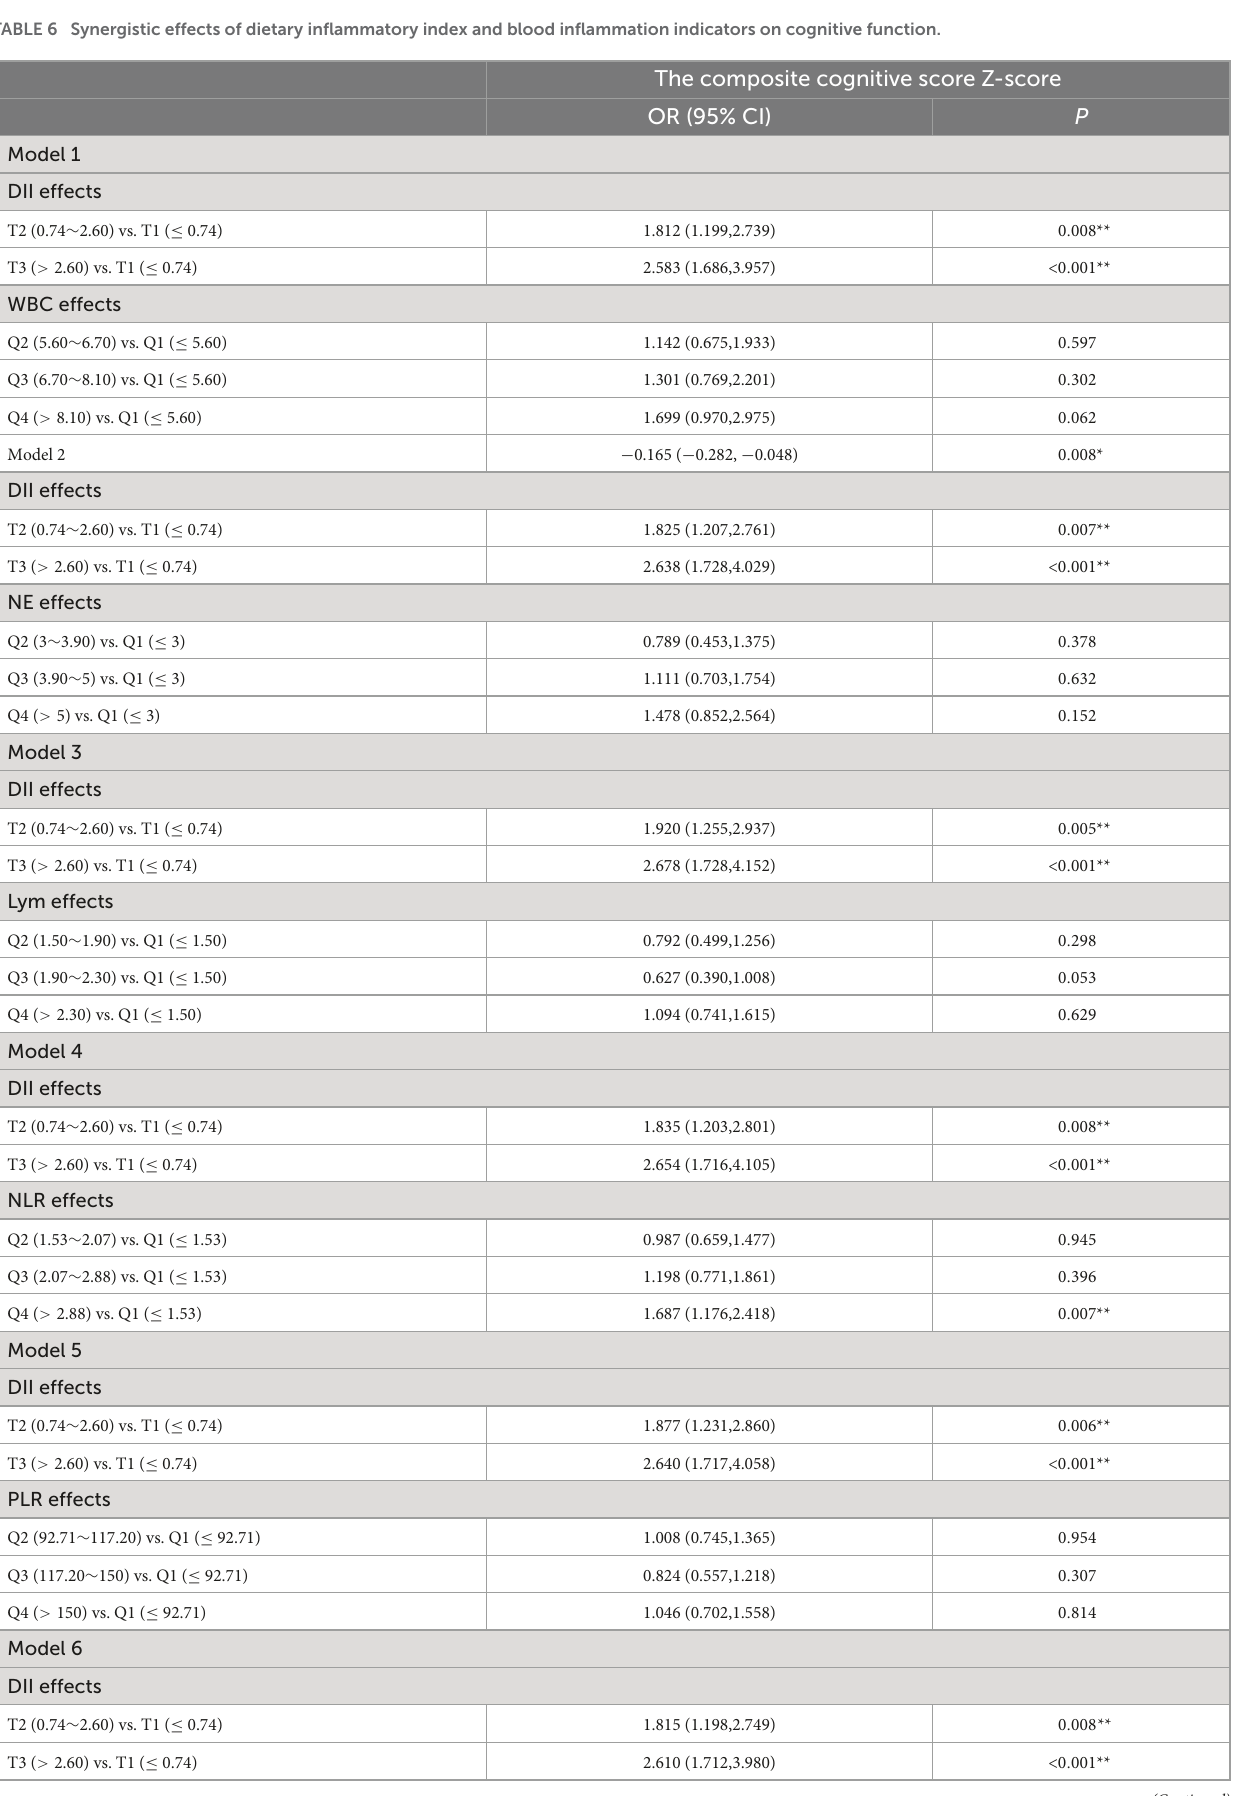
TABLE 6 Synergistic effects of dietary inflammatory index and blood inflammation indicators on cognitive function.